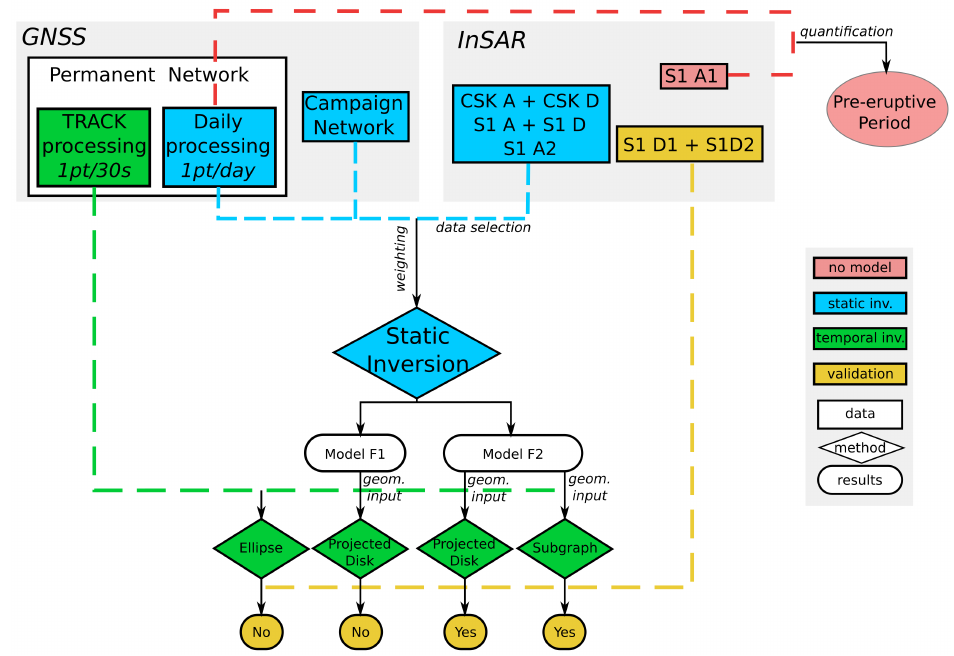
Figure 4. Use of the different data sets in our modeling